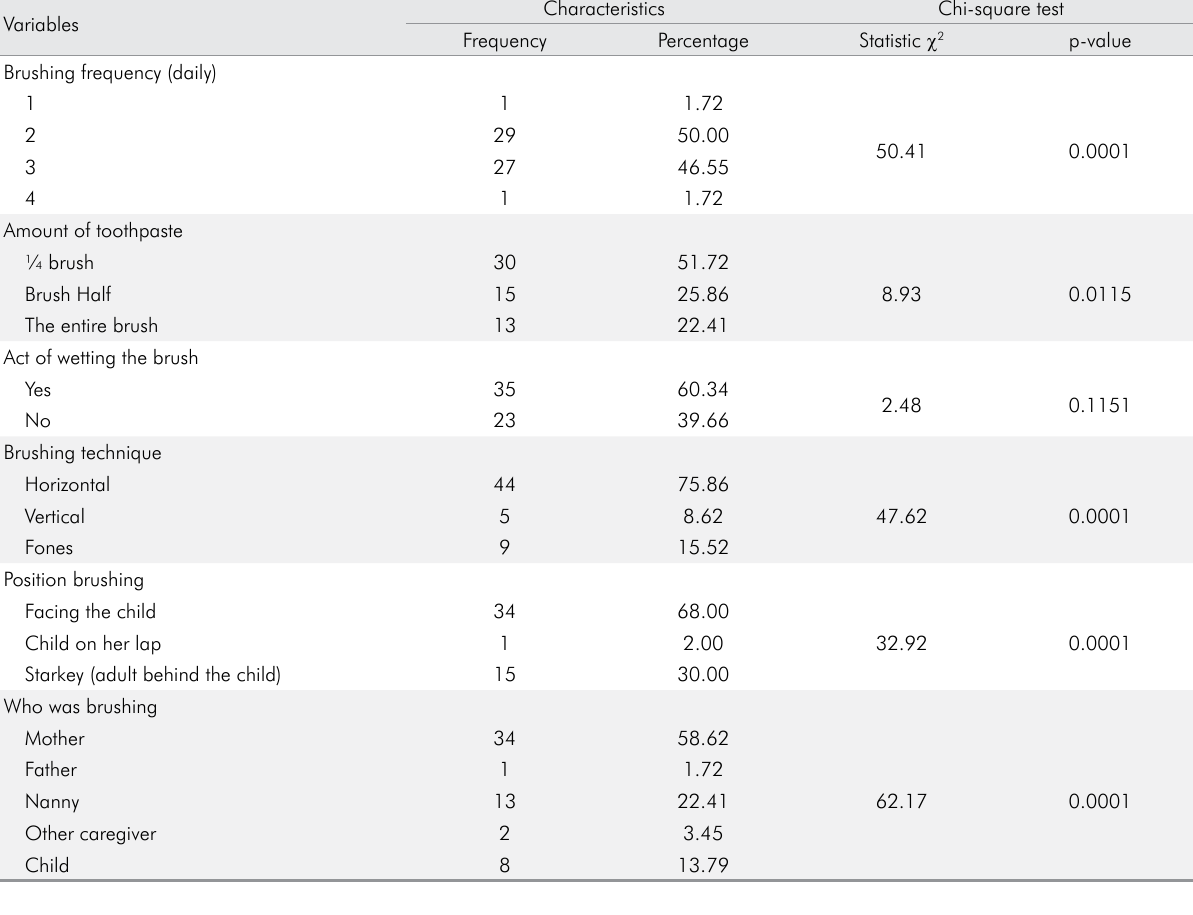
Table 3. Brushing characteristics of the sample.